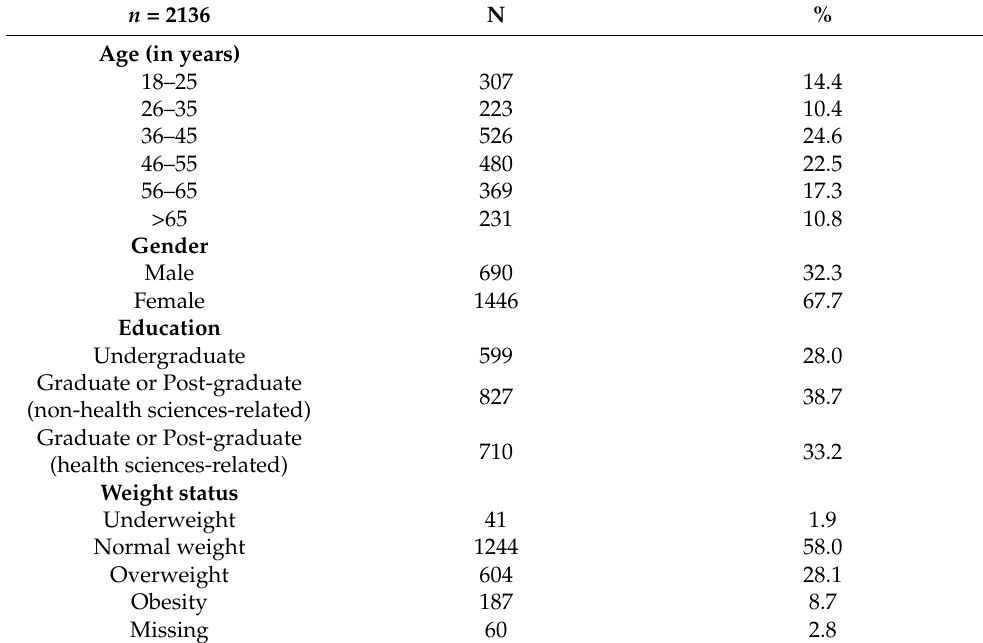
Table 1. Sample characteristics ( n = 2136).